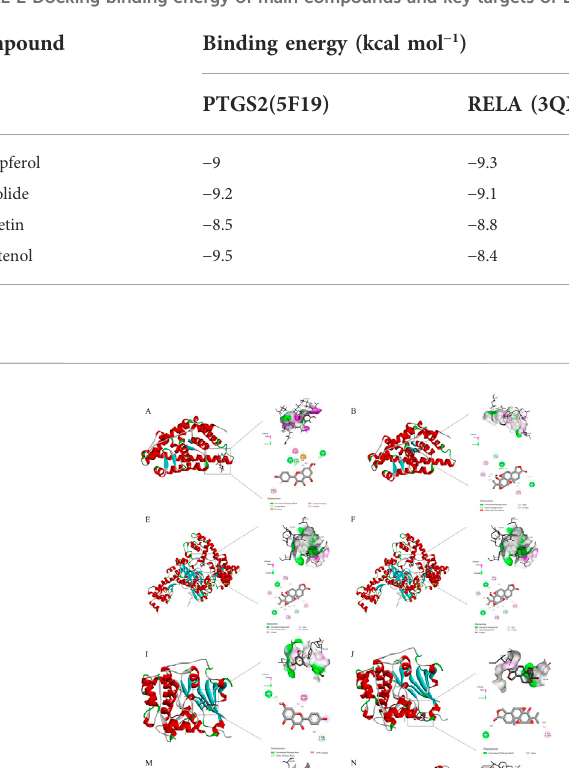
TABLE 2 Docking binding energy of main compounds and key targets of LTD.